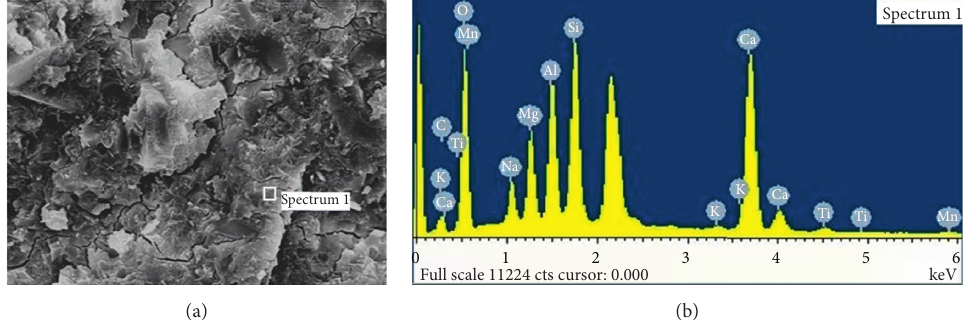
Figure 10: SEM/EDS photograph of A4S6-5M at 28d curing time.